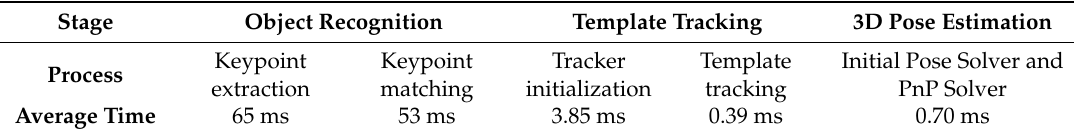
Table 2. Average processing times in each stage of the proposed